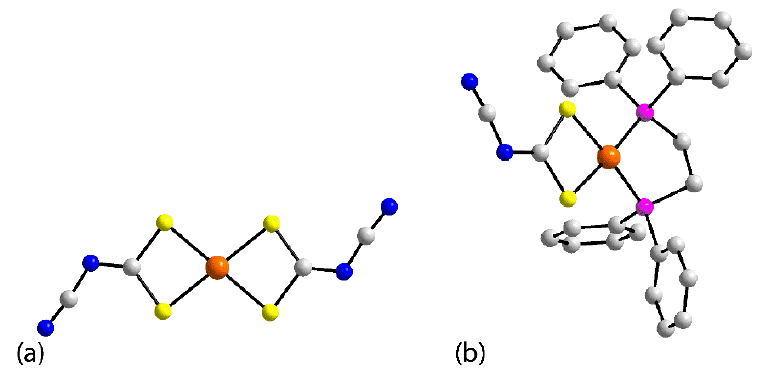
Figure 6. Molecular structures of ( a ) the {Ni[S 2 C=N(CN)] 2 } 2 − di-anion in 10 and ( b ) (dppe)Ni[S 2 C=N(CN)] ( 12 ). ( b ) (dppe)Ni[S 2 C=N(CN)] ( 12 ).